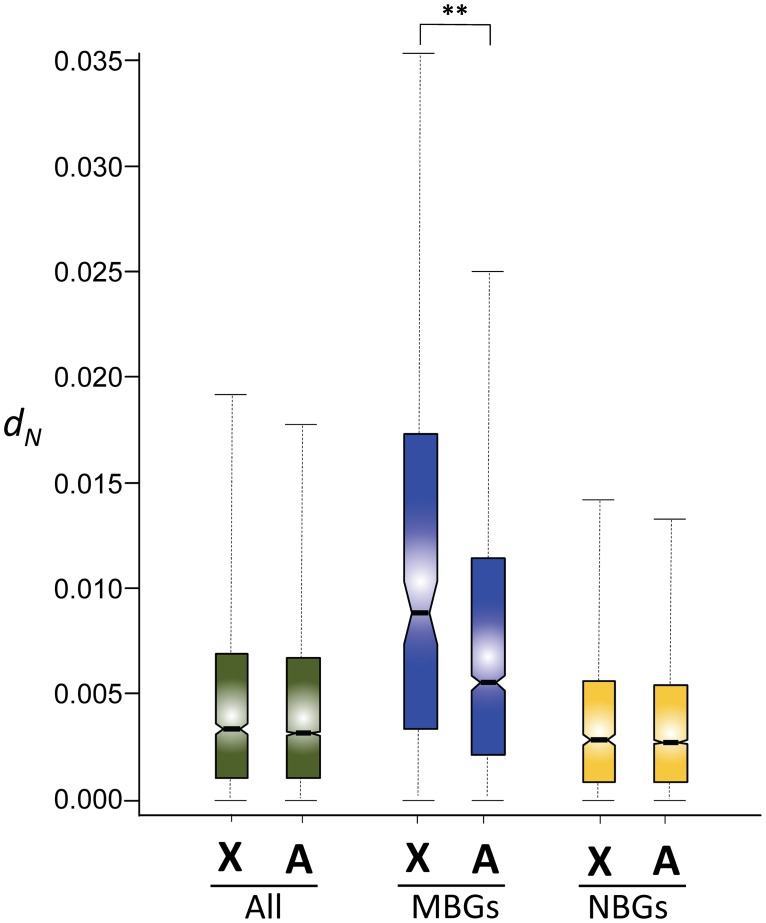
Number of nonsynonymous changes per site (d
N) between D. yakuba and D. santomea in 9,203 genes (green), male-biased genes (blue, MBGs) and nonsex-biased genes (yellow, NBGs).
X, X-linked genes; A, autosomal genes. Asterisks indicate statistically significant differences in d
N (Mann-Whitney U test, P = 1×10-6). (See Fig. 1 legend for explanation of box plots.).